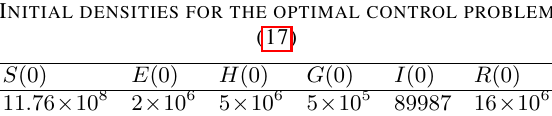
I NITIAL DENSITIES FOR THE OPTIMAL CONTROL